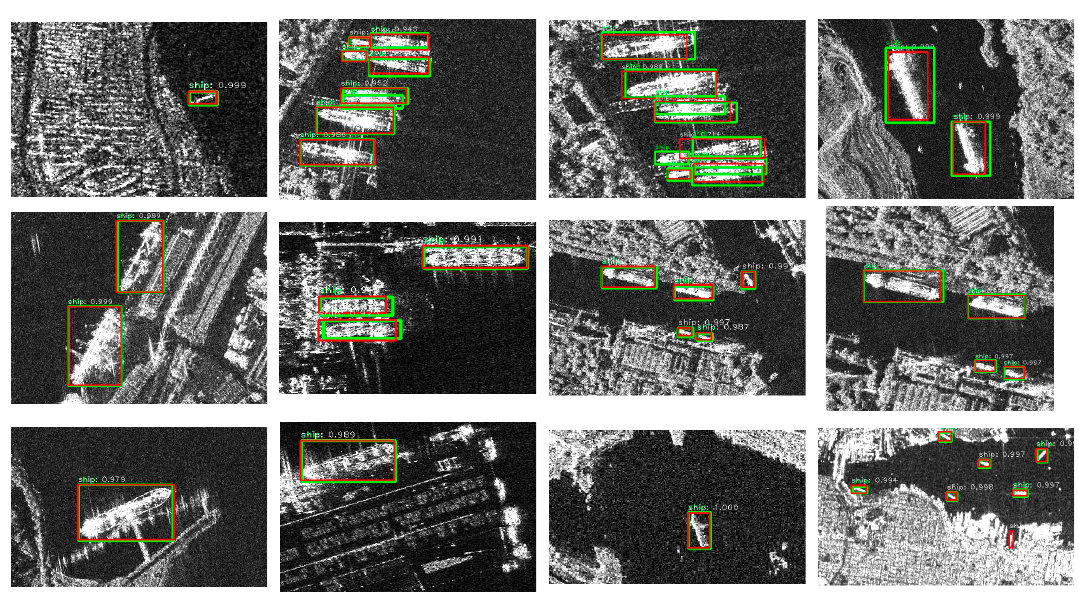
Figure 11. Ship detection results of the proposed method in the inshore and offshore scenes. Red boxes denote predicted results; green boxes denote ground-truth. Table 4. Results on SSDD for HR-SDNet which use NMS as a Baseline and the Soft-NMS Method.